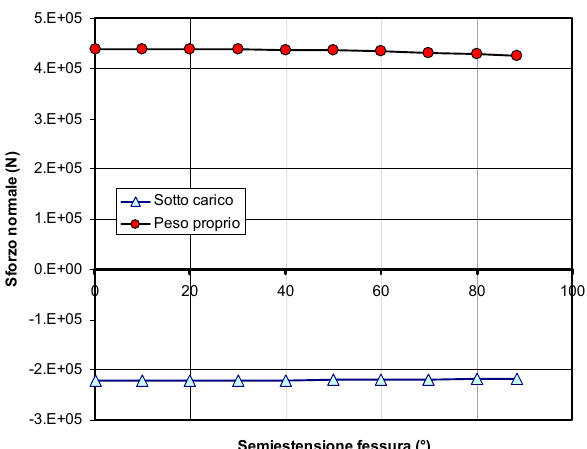
Figura 6: Sforzo normale agente nella sezione del tubo in funzione della semiampiezza del difetto; le due curve si riferiscono alle due condizioni utilizzate per definire il ciclo di carico.